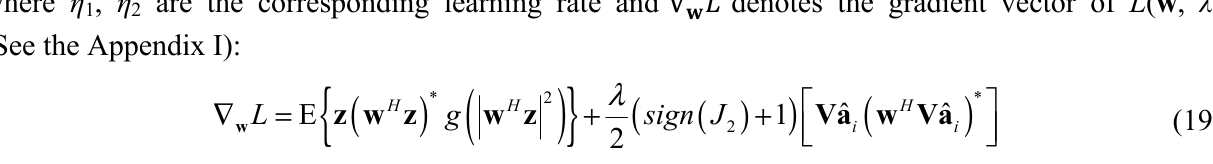
Algorithm 1. The one-unit extracting algorithm with spatial